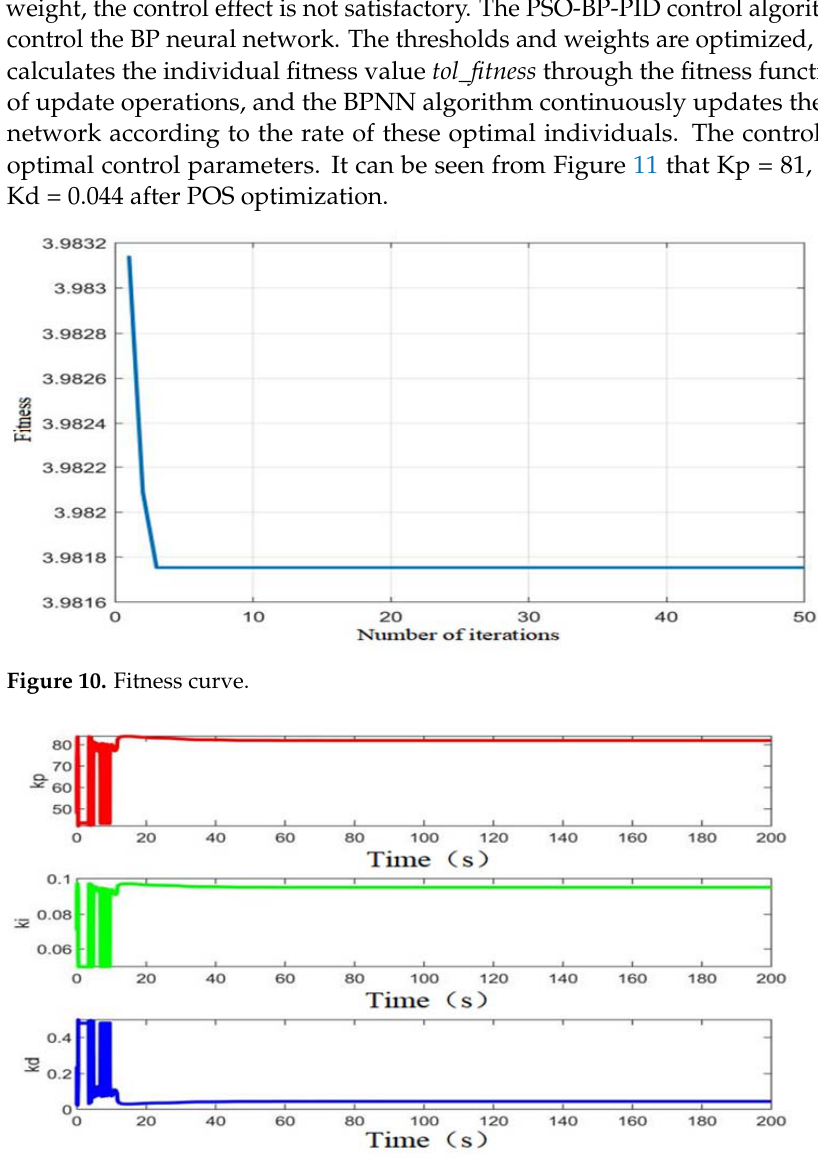
Figure 11. Kp, Ki, and Kd after PSO